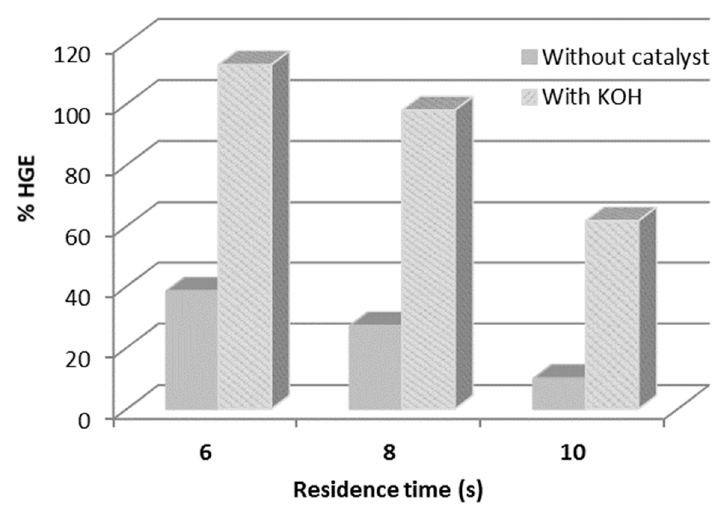
Figure 7. Effects of an alkali catalyst, specifically KOH at 0.1 wt %, on the SCWG of cellulose at 250 bar, 535 °C, with an initial concentration of cellulose = 0.3 g/L, and n = 0.4.